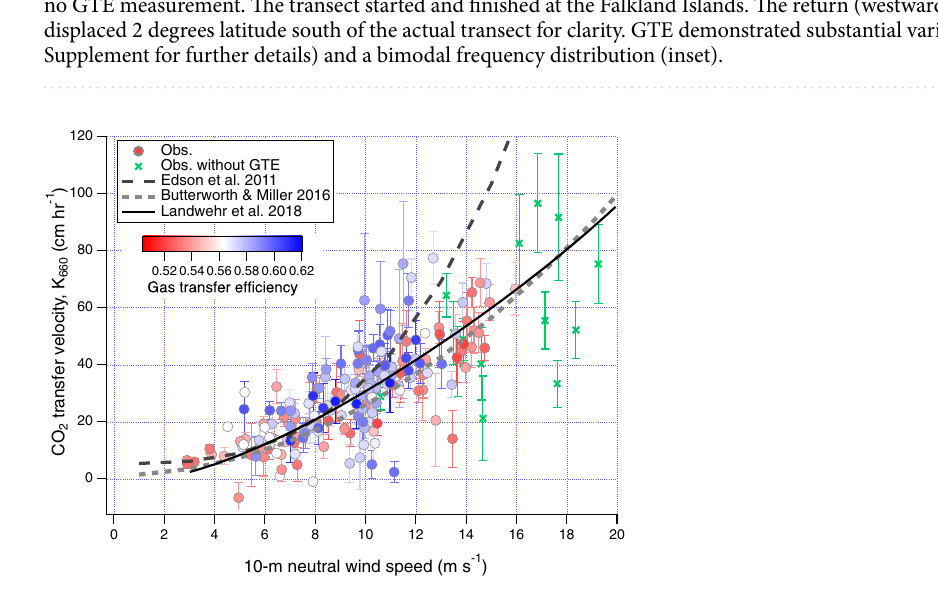
Figure 2. Air–sea CO 2 transfer velocity (hourly; n = 199) vs. 10-m neutral wind speed, scaled to a Schmidt number of 660 with an exponent of − 0.5 and colour-coded by GTE. K 660 observations without concurrent GTE measurements are denoted with crosses. K 660 tends to be reduced when GTE was low, and vice versa. Also shown are the wind speed dependences from three direct measurements of CO 2 K 660 , from ref. 9–11 . The error bars on K 660 are propagated from the empirically estimated EC flux uncertainty (see ref. 37